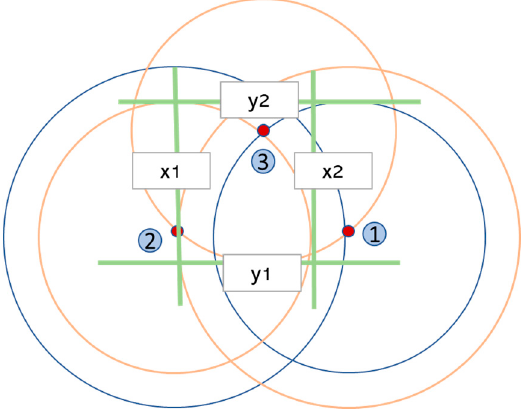
Figure 11. Initial region of the area (2,1,1).